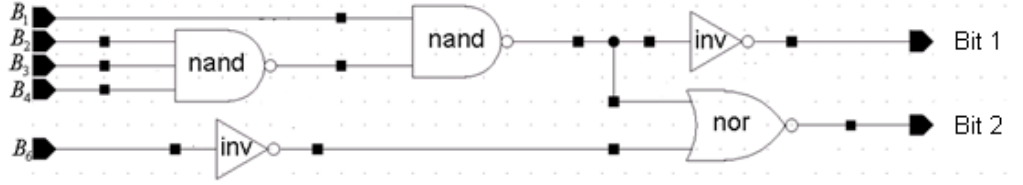
Figure 11. The Boolean logic circuit to realize the binary pattern recognition for the sampling-and-hold sensor